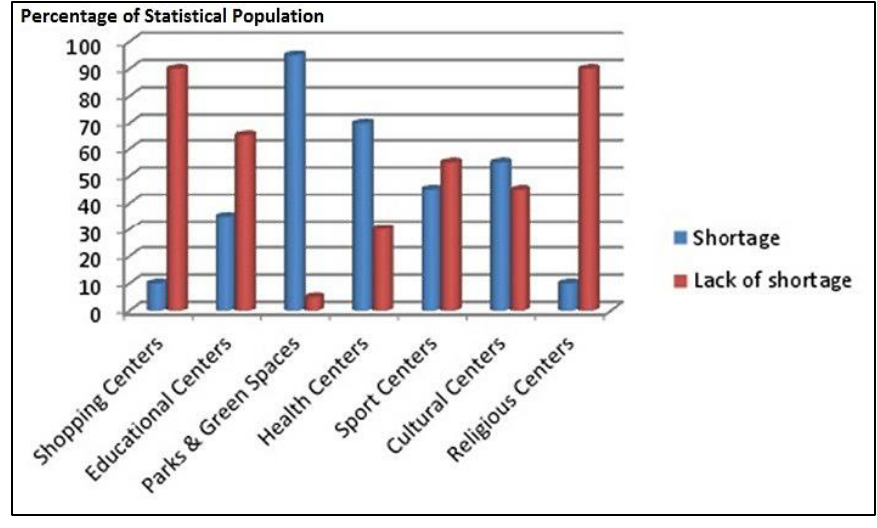
Figure 10. Physical Requirements of Neighbourhood from the Viewpoint of Residents